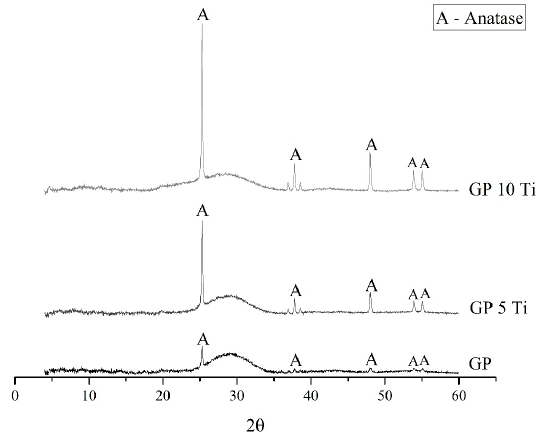
Figure 8. XRD pattern of the synthesized geopolymers.